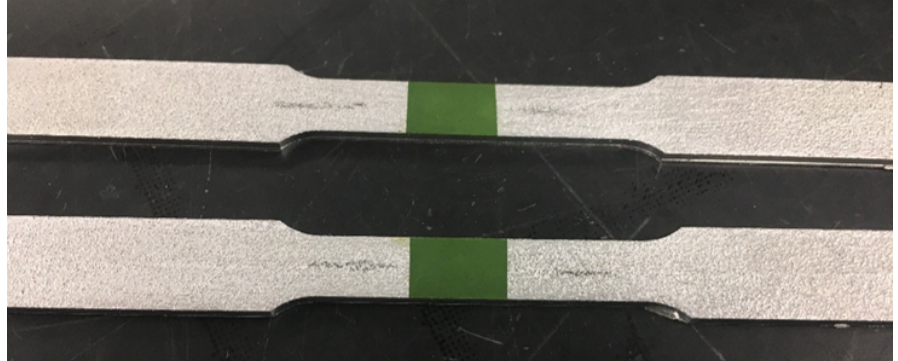
Figure 8. Elevated-temperature coupons built using UAM with a high-temperature strain gauge affixed to the outside of each coupon. FBG fibers are embedded down the length of each